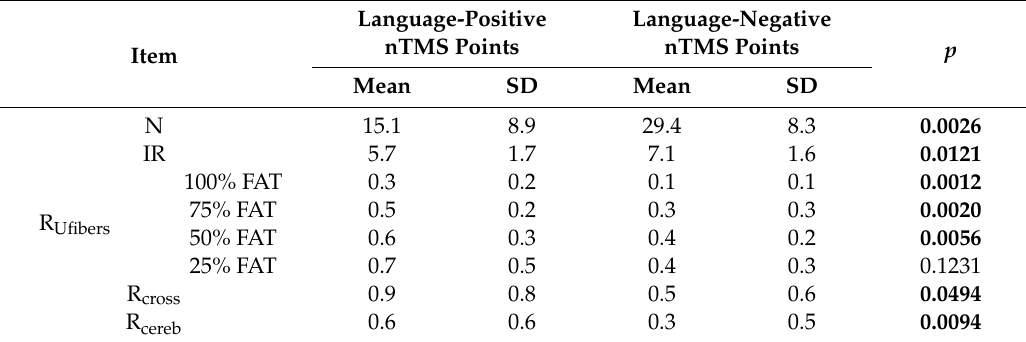
Table 2. Comparison between language-positive and language-negative mapping and tractography.